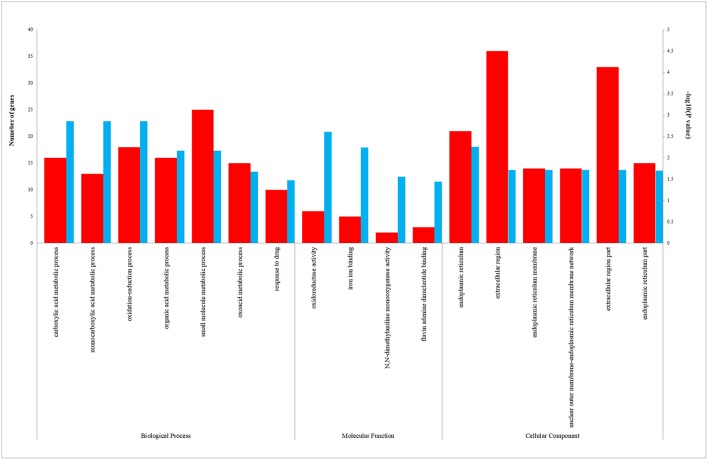
The enriched biological process (BP), molecular function (MF), and cellular component (CC) terms in GO analysis. The red column represents the number of genes enriched in GO term. The blue column represents the –log10(P-value) of GO term.